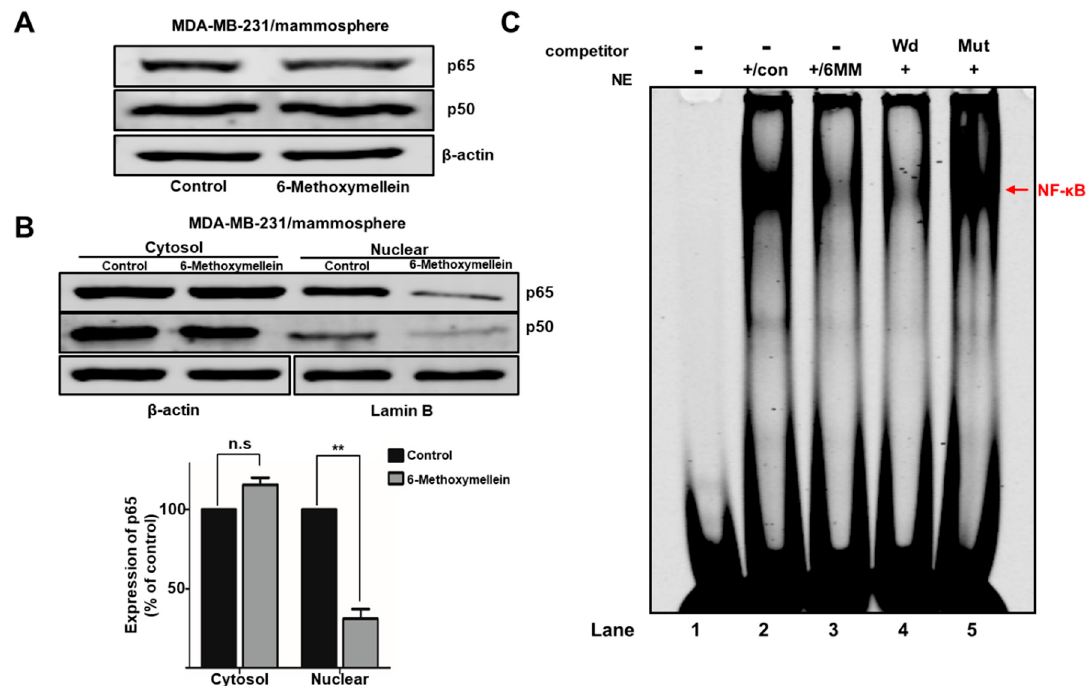
Figure 6. The effect of 6-methoxymellein on the NF- κ B signaling pathway. ( A ) The total protein level of NF- κ B p65 and NF- κ B p50 were assayed in mammospheres under 6-methoxymellein for 48 h using immunoblot analysis. ( B ) The levels of nuclear NF- κ B p65 and NF- κ B p50 were assayed in mammospheres under 6-methoxymellein (1 mM) or DMSO. 6-Methoxymellein blocks the translocation of NF- κ B p65 and NF- κ B p50 in mammospheres. ( C ) EMSAs of nuclear protein in MDA-MB-231 cell-derived mammospheres under 6-methoxymellein. The nuclear extracts were incubated with the NF- κ B probe and run by 4% native PAGE. Lane 1: IR700-NF- κ B probe only; lane 2: nuclear extracts with the IR700-NF- κ B probe; lane 3: 6-methoxymellein-treated nuclear proteins with the IR700-NF- κ B probe; lane 4: untreated nuclear proteins incubated with the self-competitor (100 × ) oligo; lane 5: untreated nuclear extracts incubated with the mutated-NF- κ B (100 × ) oligo. The arrow shows the DNA / NF- κ B protein complex from nuclear lysates of mammospheres. Our data are presented as the mean ± SD of three independent experiments. ** p < 0.05 versus the control